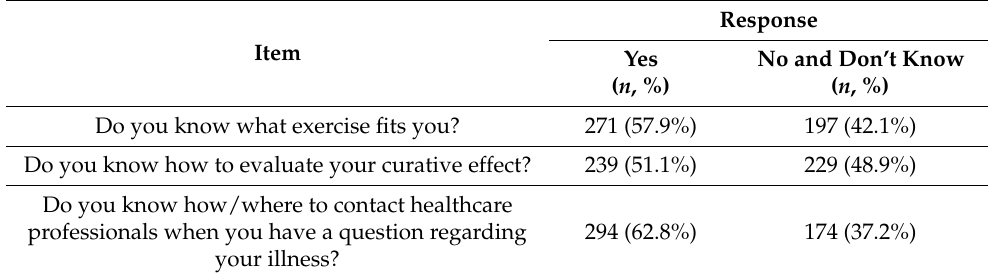
Table 5. Awareness of the participants regarding management of the CKD disease